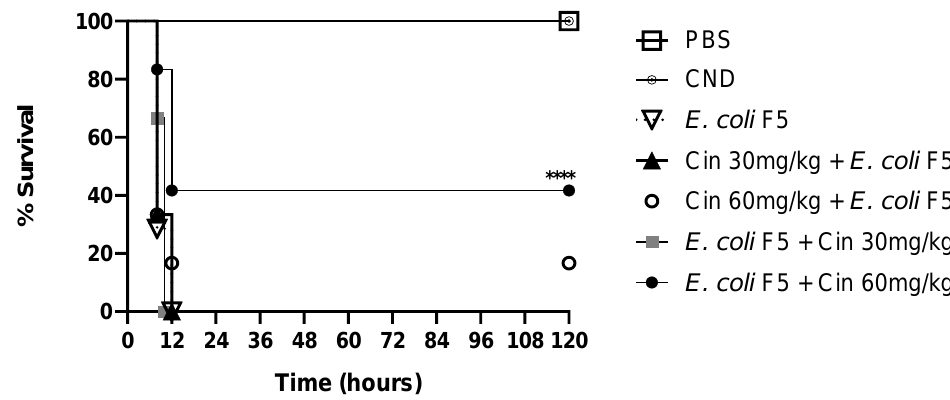
Figure 1. Survival curve of animals infected with E. coli F5 and cinnamaldehyde treatment. The mice used in the experiment were distributed into seven groups ( n = 6). The animals in the non-infected control groups received PBS or cinnamaldehyde (CIN 60 mg/kg). The remaining 3 groups were infected with E. coli F5. Prophylactic cinnamaldehyde groups received 30 (prophylactic CIN 30) and 60 mg/kg (prophylactic CIN 60) of cinnamaldehyde, 5 days before the infection, and therapeutic cinnamaldehyde groups were treated with 30 (therapeutic CIN 30) and 60 mg/kg (therapeutic CIN 60) of cinnamaldehyde, 2 h after E. coli F5 infection. Then, the survival was evaluated every 12 h until the 5th day after infection. **** p < 0.0001 as compared with the E. coli F5